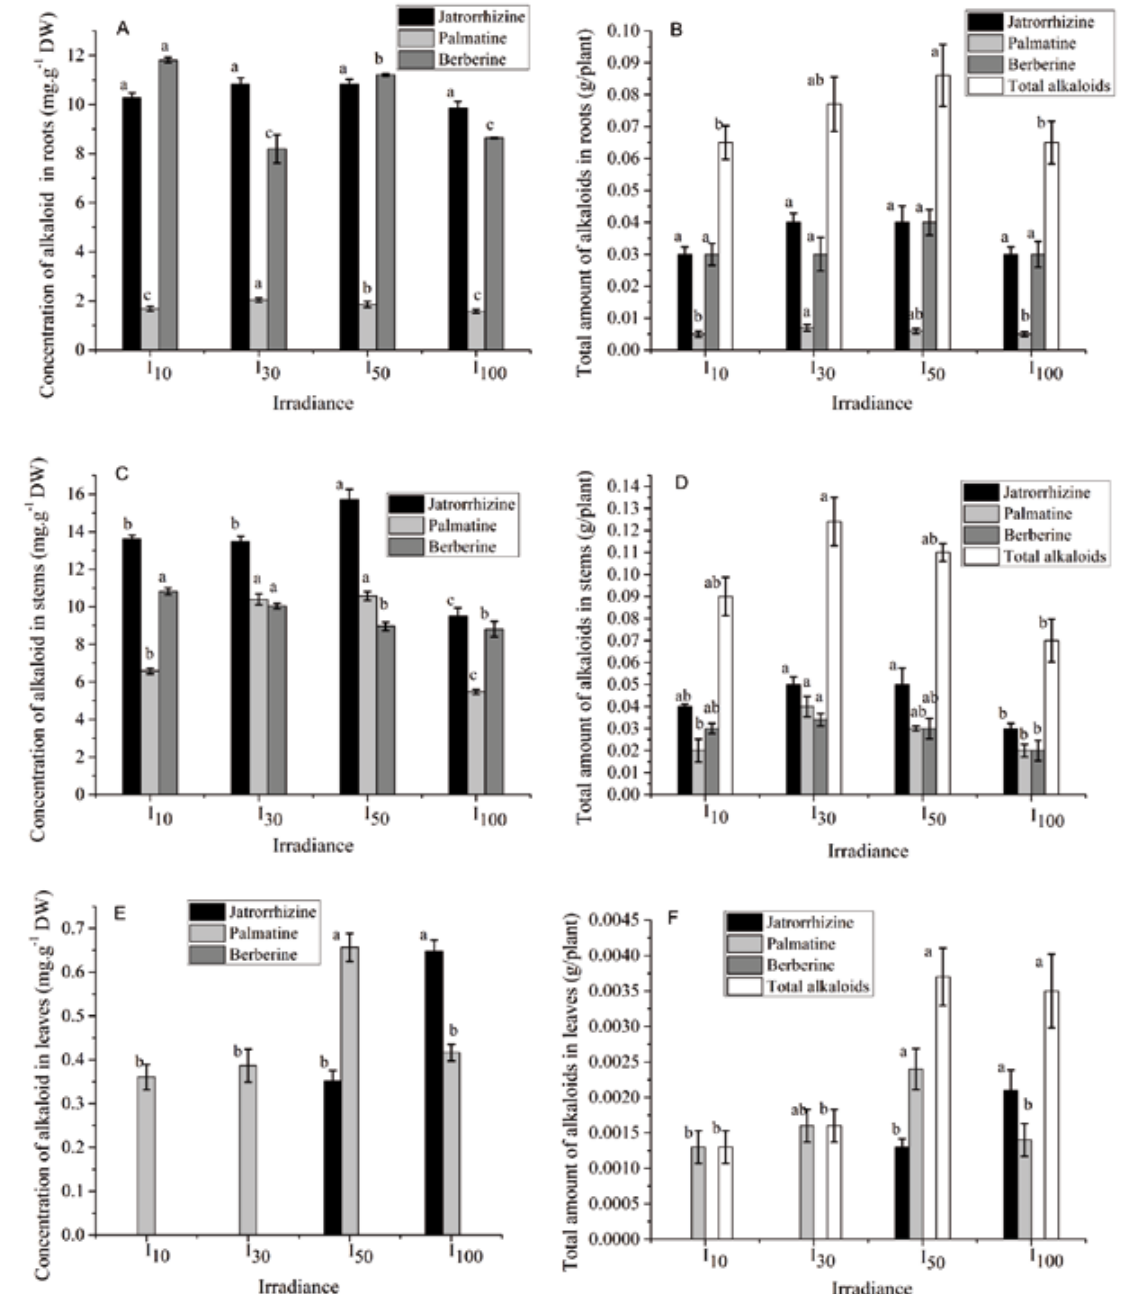
Fig. 2: Levels of three alkaloids in M. breviracema roots (A), stems (C) and leaves (E) at various light levels. Estimated total amounts of alkaloid in the roots (B), stems (D) and leaves (F) of a plant under different light intensities (g per plant). The values are the average ± SE. Different letters demonstrate that there are obvious differences in the shade treatments (P<0.05)